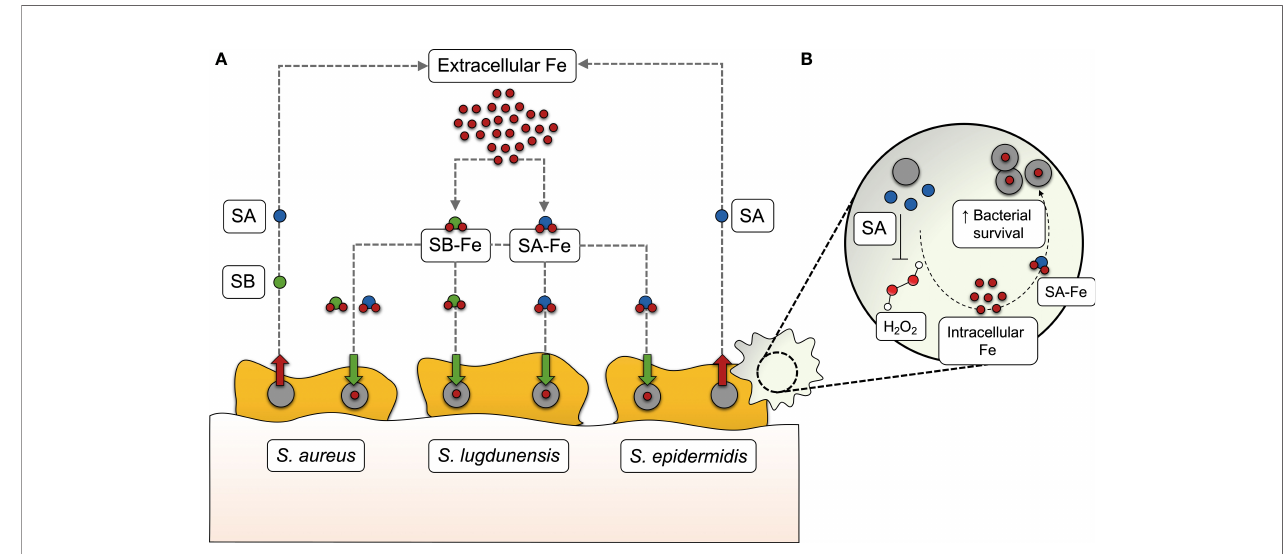
FIGURE 1 | Siderophore-mediated iron acquisition in staphylococci. (A) While S. aureus produces two different siderophores (staphyloferrin A, SA, and staphyloferrin B, SB), S. epidermidis synthesizes SA only, and S. lugdunensis hijacks SA and SB from these two staphylococci species instead of producing them. After being secreted into the extracellular medium, SA and SB bind to extracellular iron (Fe) and make their way back to the cell as siderophore-iron complexes (SA-Fe and SB-Fe), providing the iron levels required for several bacterial processes, including bio fi lm formation. (B) In S. epidermidis , SA-mediated iron acquisition has recently been found to contribute to bacterial survival in human macrophages, by withstanding the action of certain reactive oxygen species, such as hydrogen peroxide (H 2 O 2